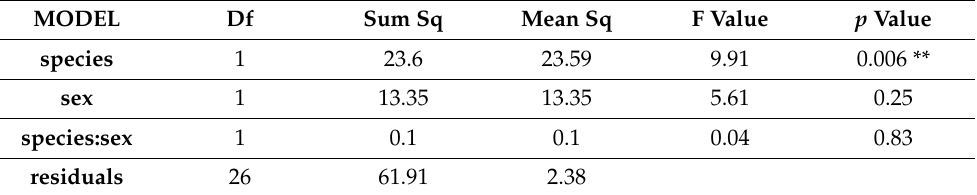
Table 3. GLM fitted with aov on PCA scores of immune parameters of two crayfish species. Significant differences ( p < 0.01) are indicated with **. Df = degrees of freedom, Sum Sq = sum of squares, Mean Sq = mean